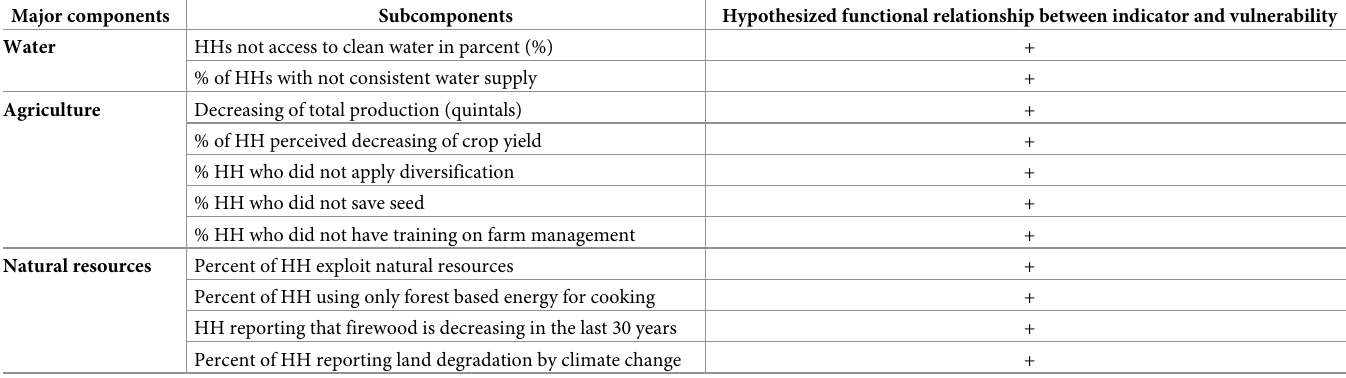
Table 3. Sensitivity major components, sub-components, and their hypothesized effect with vulnerability. Major